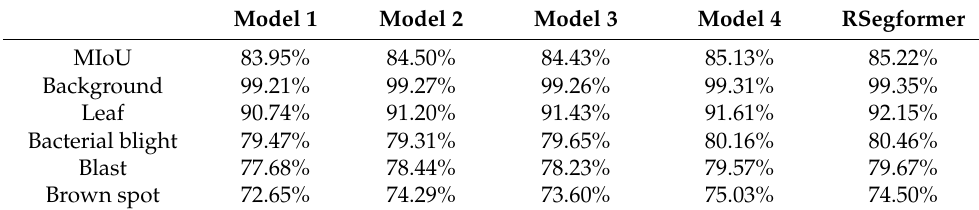
Table 6. MIoU comparison in ablation study when removing some